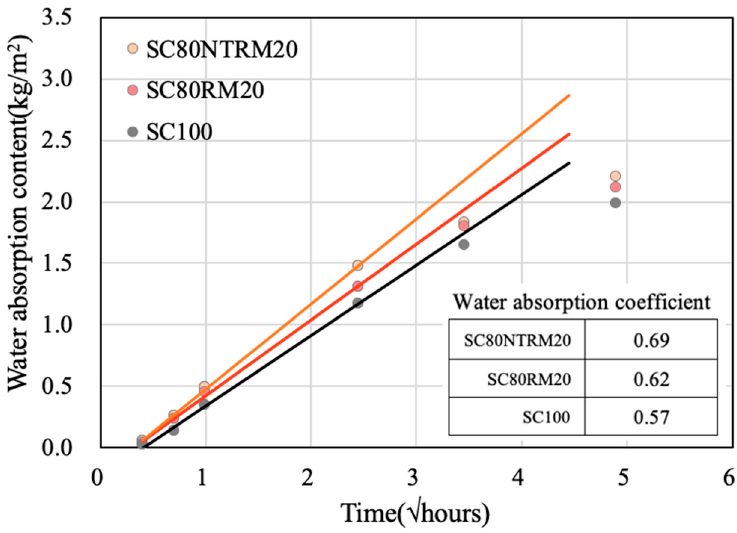
Figure 10. Water absorption coefficients of SC100, SC80RM20, and SC80NTRM20.